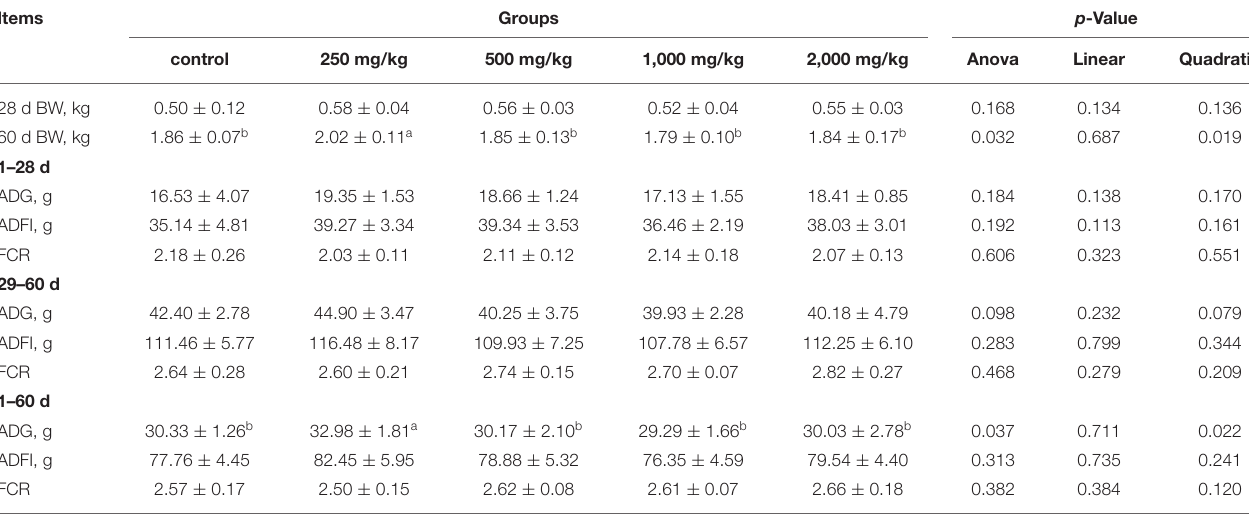
TABLE 2 | Effects of dietary Galla chinensis extract (GCE) supplementation at different levels on growth performance of broilers. Items Groups